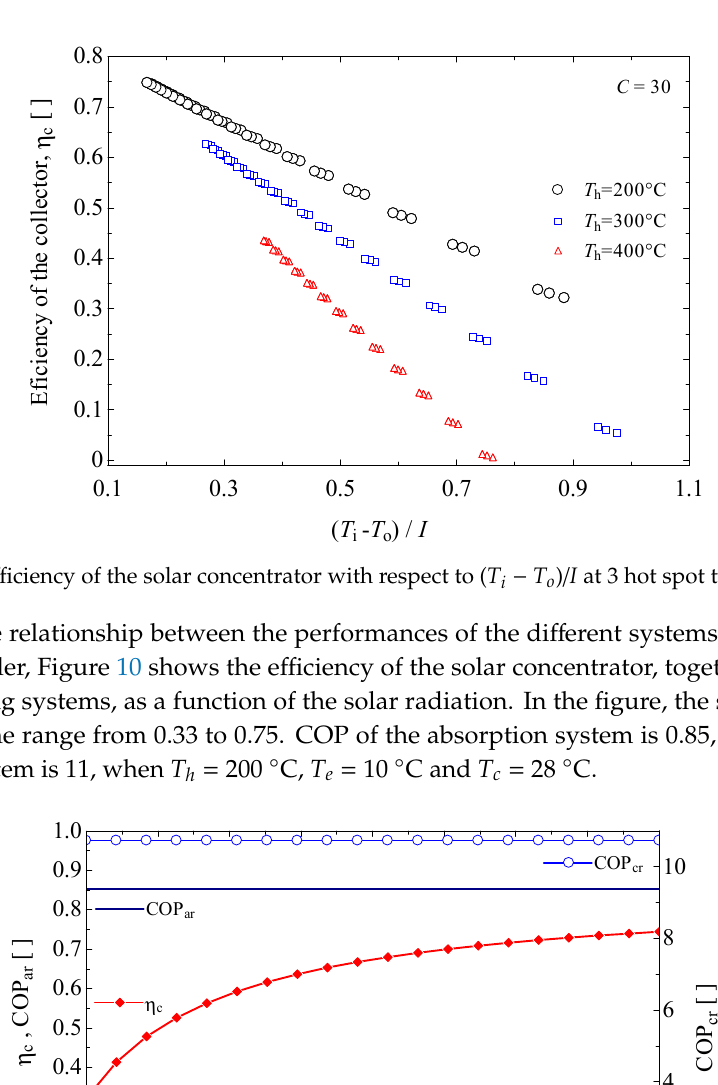
Figure 11. Efficiency of the solar collector and cooling systems, with respect to radiation in the solar concentrator. The energy savings of the proposed hybrid chiller were determined in comparison to a commercial air conditioning equipment of 0.75 tons of refrigeration (2636 kW) [32]. The cooling capacity of the hybrid system is 2.72 kW (0.47 kW in the absorption evaporator and 2.25 kW in the compression evaporator). The electricity consumption of the compressor was 0.85 kW, taken from [32], while the electricity consumption of the solution pump was P E = 0.032 kW, obtained from Figure 5, at the maximum recommended operating value of the absorption system, x a = 0.4, with T c = 37 °C and T e = 15 °C ( P E = P p / η p = 0.028/0.85). The cost of electricity in American dollars ($) per kWh in Mexico was taken from [33]. The energy savings of the proposed chiller, shown in Figure 12, were determined considering an operating period of 8 h per day, as recommended in [34], during 365 days per year. In Figure 12, it can be seen that electricity consumption of the conventional system is 26.6 times the consumption of the hybrid system. In cumulative values, with this difference in annual consumption,